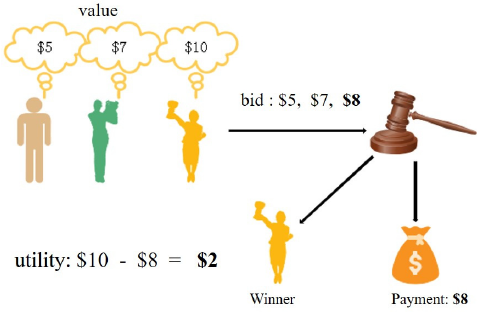
Figure 3. First − price auction of a single dimension.